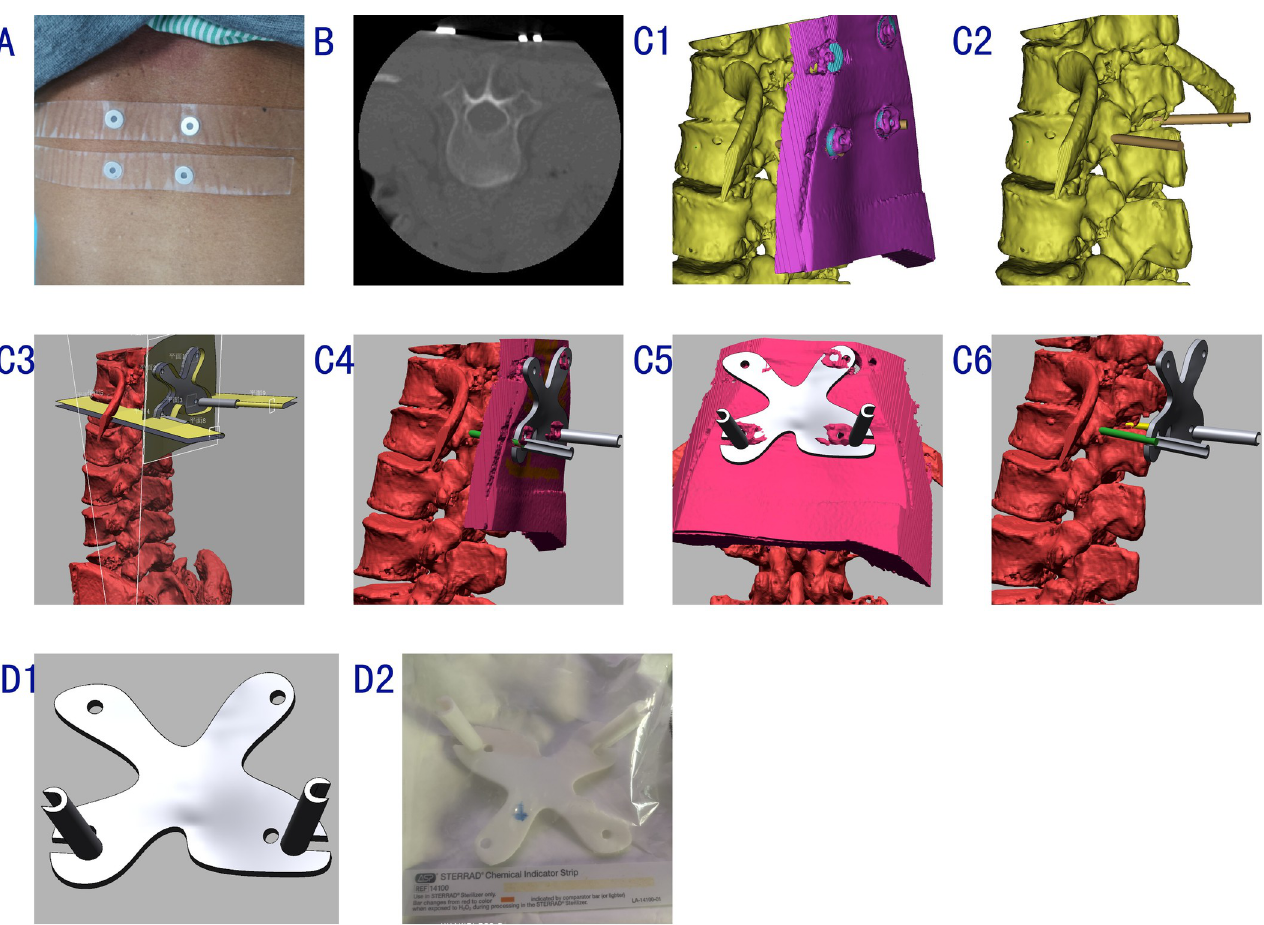
Fig 1. A : For active positioning, four or more concentric hollow metal spacers were affixed to the skin surface near the target vertebral body; for point positioning, a waterproof marker was used to mark the skin at the centers of the spacers. B : CT examination was performed with the patient on a supine cushion. C1 : The vertebral model was imported from the reconstruction software in STL format. C2 : Simulation of the working channel. C3 : The gasket and skin model was imported in STL format for the fabrication of the coplanar guide plate and positioning of holes. C4, 5 : Guide plate design. D1 : The guide plate was printed with environmentally friendly PLA material at a ratio of 1:1. D2 : The guide plate used in surgery was sterilized at low temperature.